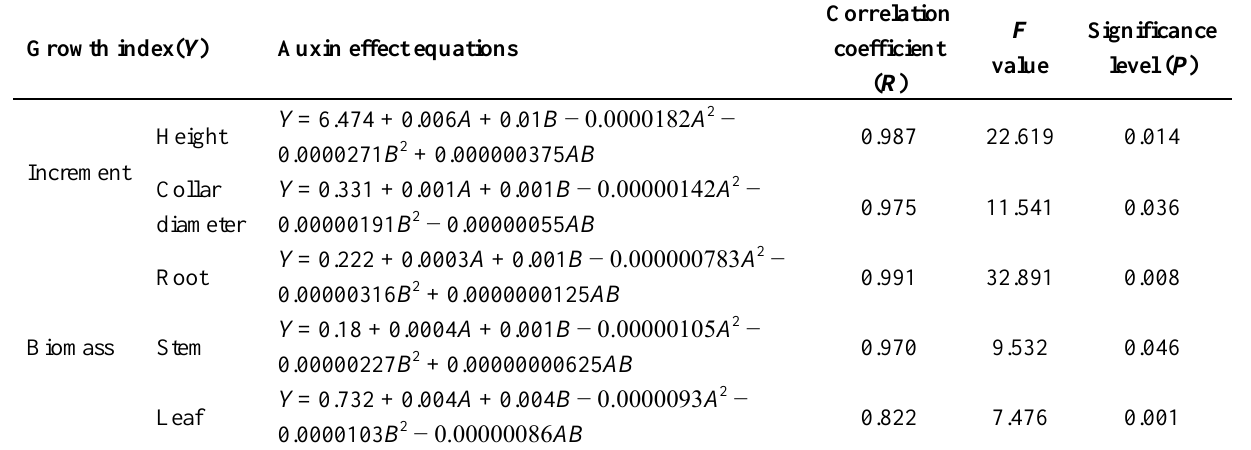
Table 1. Auxin effect equations for the growth index of Yunnan